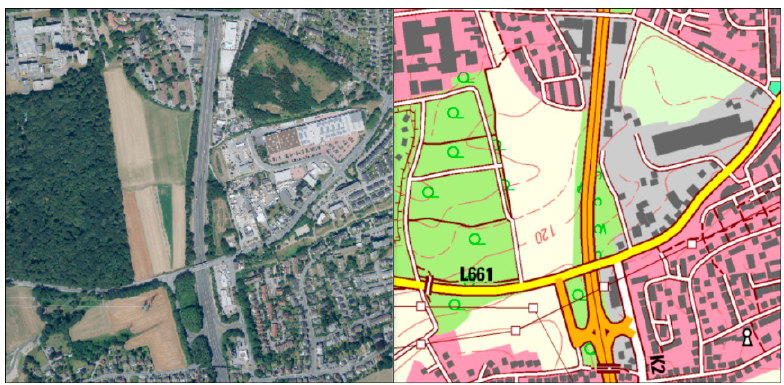
Figure 5. Aerial photograph and resulting topographical map [17].